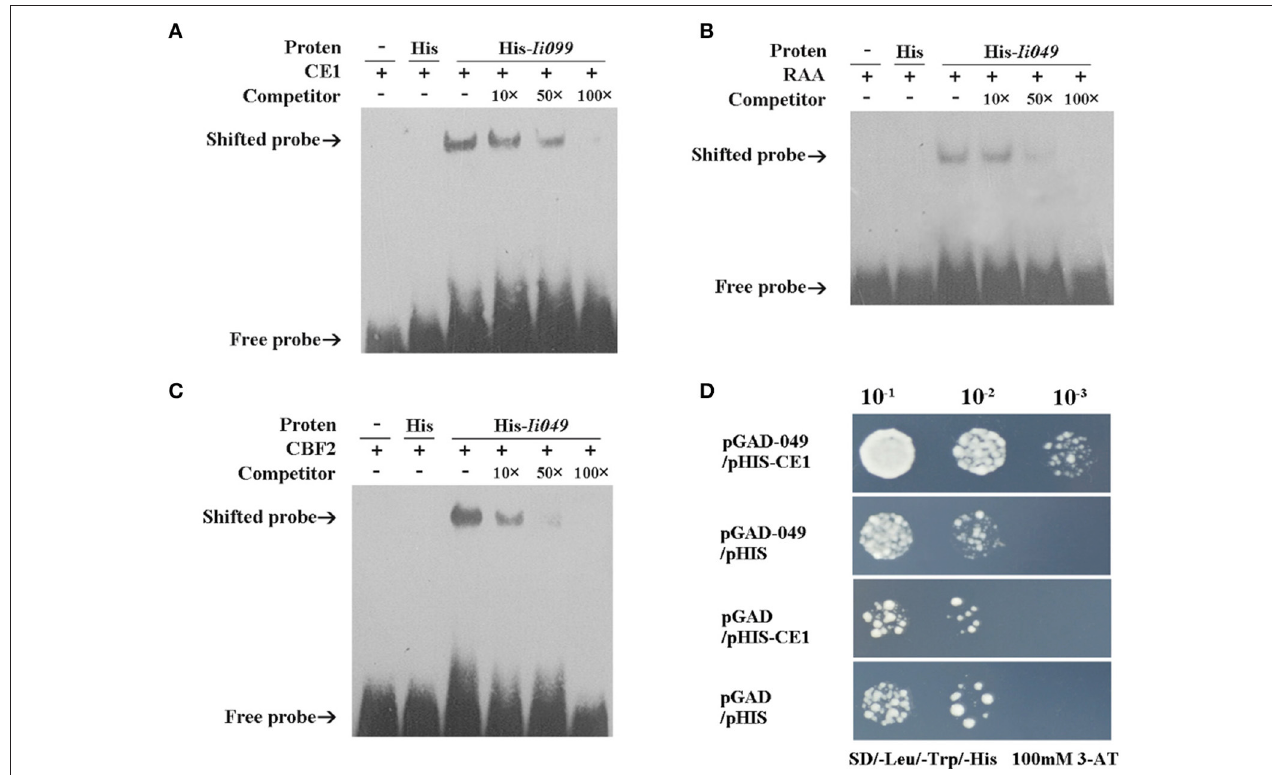
FIGURE 6 | Ii049 protein bound to CE1, RAA, and CBF2 motifs. (A–C) The EMSA assay of Ii049 protein using biotinylated double-stranded CE1 (A) , RAA (B) , and CBF2 (C) probes, respectively. The detection of probes after reaction with His protein was taken as a negative control. Then, 10 µ g of biotin-labeled were incubated with fusion protein at 25 ◦ C for 20min to compete with cold probes (0, 10, 50, 100 × ) and then analyzed using EMSA. The bands were clarified with a solid black arrow. (D) Y1H assay for the interaction between His- Ii049 with CE1 motif. Triple CE1 motifs were used as bait. Yeast cells carrying pGADT7- Ii049 and pHIS2-CE1 grew normally on SD-Trp-Ura-His with 100 mM of 3-AT when diluted 1,000 times. Blank pGADT7 and PHIS2 were used as negative controls.